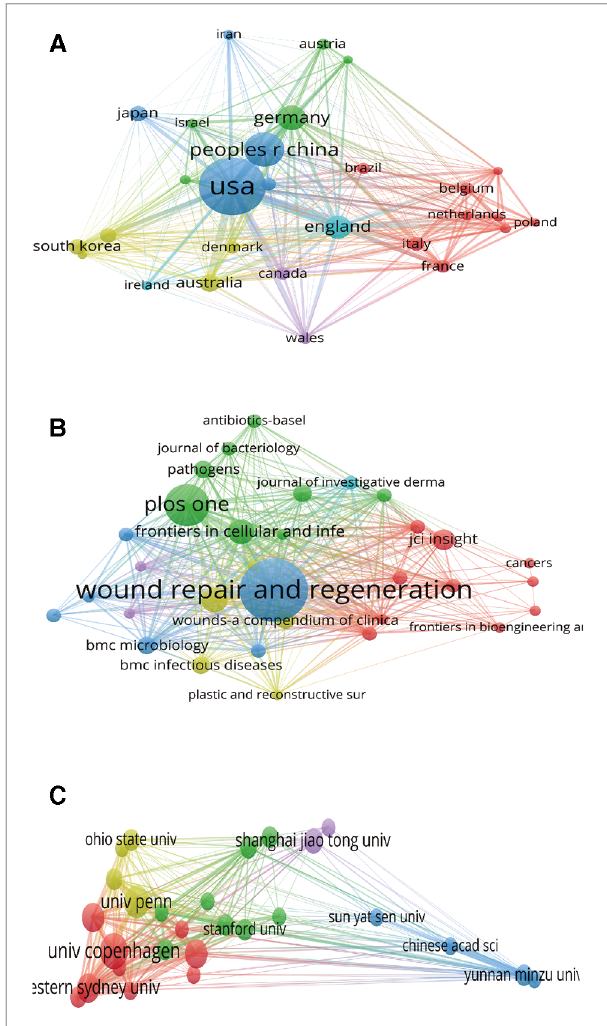
FIGURE 4 Mapping of bibliographic coupling analysis of HTS technology associated with chronic wounds. ( A ) Mapping of the 28 identi fi ed countries. ( B ) Mapping of the 32 identi fi ed journals. ( C ) Mapping of the 27 identi fi ed